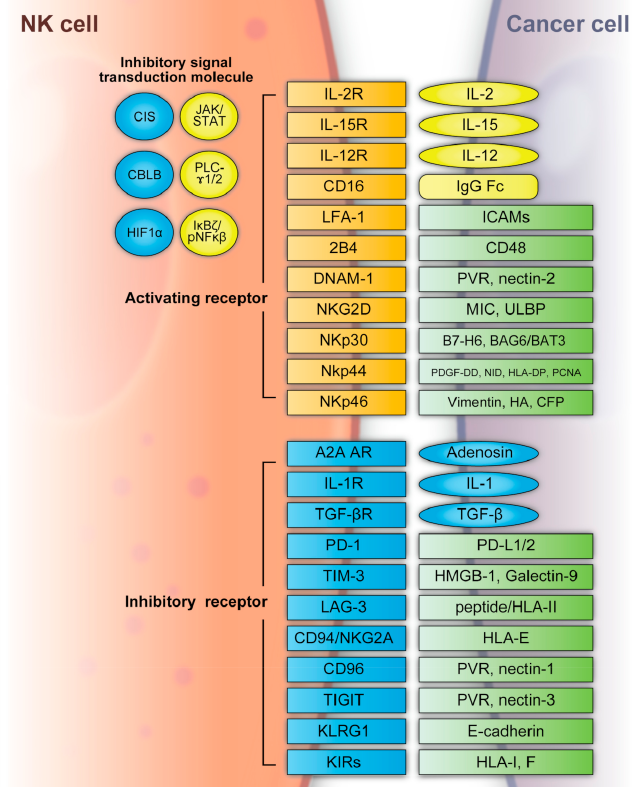
Figure 2. NK cell activating and inhibitory receptors. NK cells recognize tumor cells based on a balance between the stimulatory and inhibitory receptors above. A2A AR: A2A adenosine receptor, BAG6/BAT3: BCL2-associated athanogene cochaperone 6, CBLB: Casitas B-lineage lymphoma pro- oncogene-b, CIS: cytokine-inducible SH2-containing protein, DNAM1: DNAX accessory molecule 1, HA: IV hemagglutinin, HIF1 α : hypoxia-inducible factor 1 α , HLA: human leukocyte